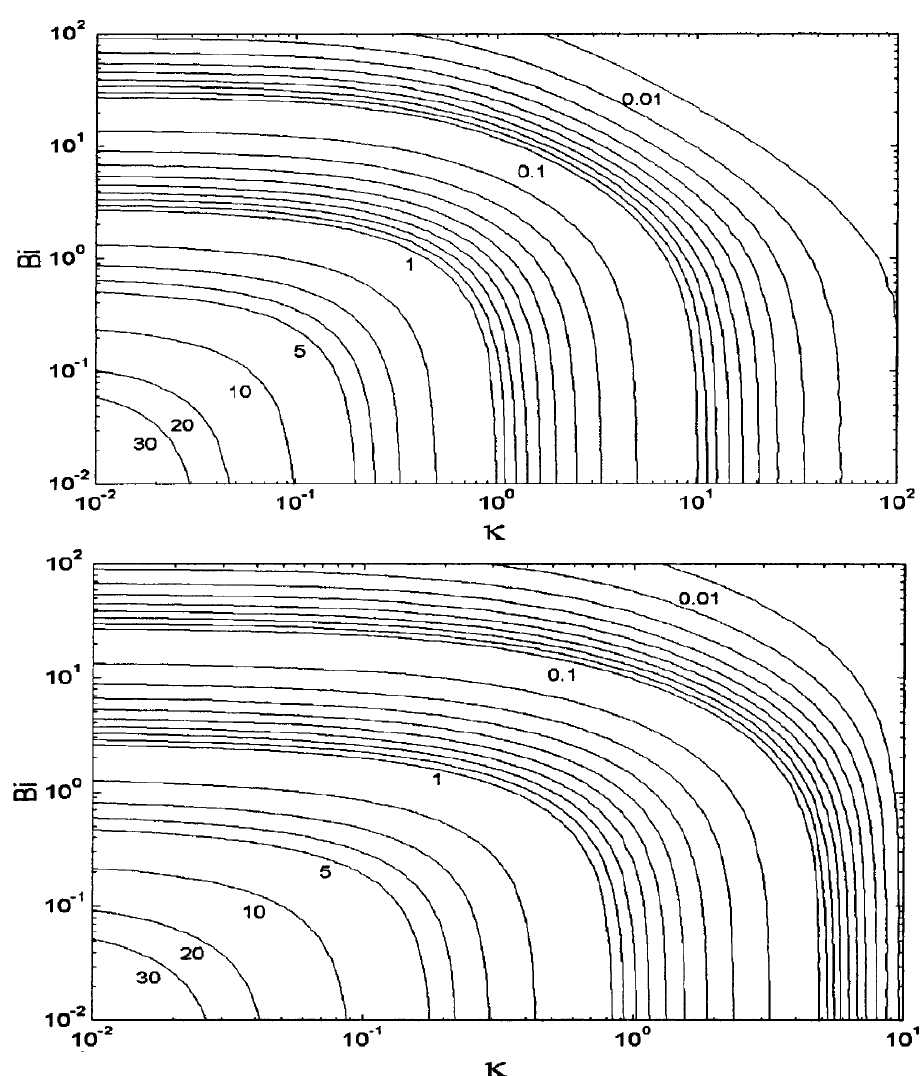
Figure 14. Error map of Nusselt number as a function of fluid/solid thermal conductivity ratio ( k ) and Biot number (Bi), for Darcy number of ( Top ) Da = 10 − 2 and ( Bottom ) Da = 10 − 4 , at Λ = 10, reported by Marafie and Vafai